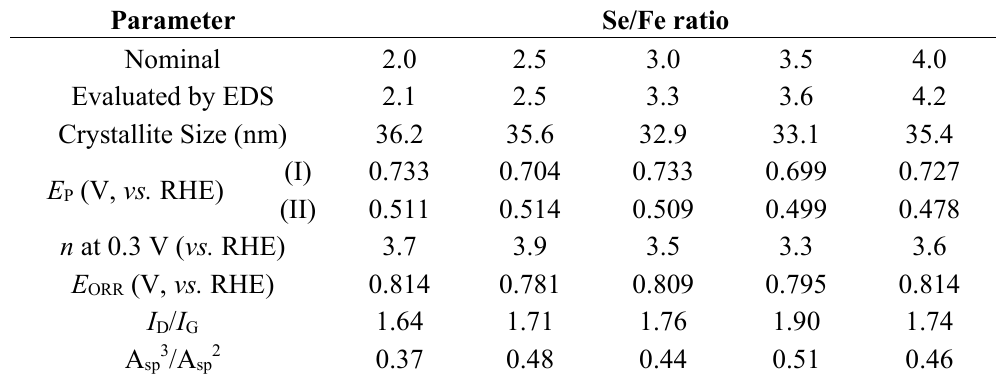
Figure 1. Typical powder XRD patterns of FeSe 2 /C prepared with different Se/Fe ratios. The standard lines of orthogonal FeSe 2 phase are included for comparison. ( a ) Full range in 10°–90°; ( b ) Enlarged in 25°–50°. Table 1. Parameters of iron selenide catalysts (FeSe 2 /C) prepared with different Se/Fe